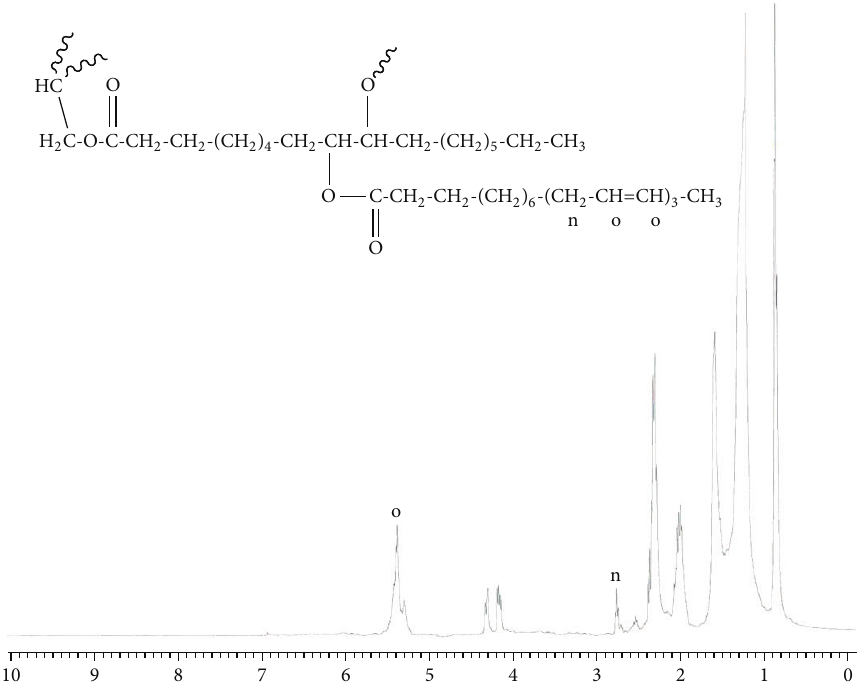
Figure 3: 1 H-NMR spectra of